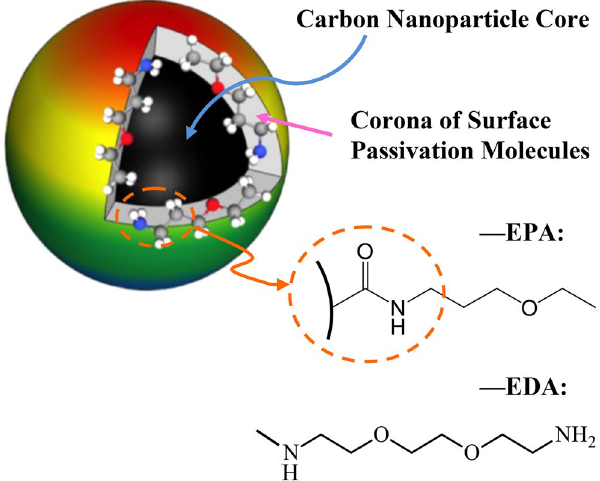
Figure 1. Schematic structure of a CDot. It consists of a carbon nanoparticle core and a thin layer of attached surface passivation molecules (EDA and EPA molecules specifically in this